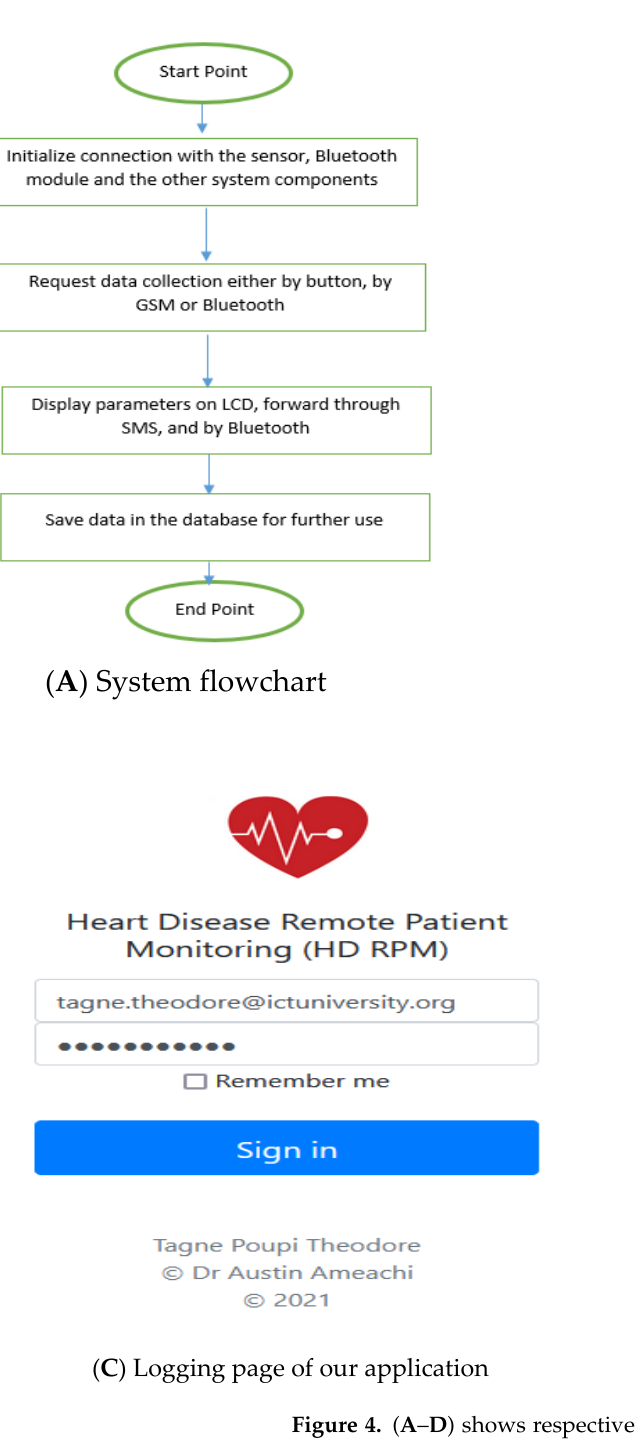
Figure 5. Confirmation of the correct data transmission. With regards to the application interface, to create a communication with the sensor and server, a web application was developed to serve as an interface. Our application here is called “heart disease RPM” and permits the medical expert, herein a cardiologist, to access the patient’s data. The app’s welcome and registration pages are shown in Figure 6A. In order to create an account, the patient must fill out the form. Basic details including